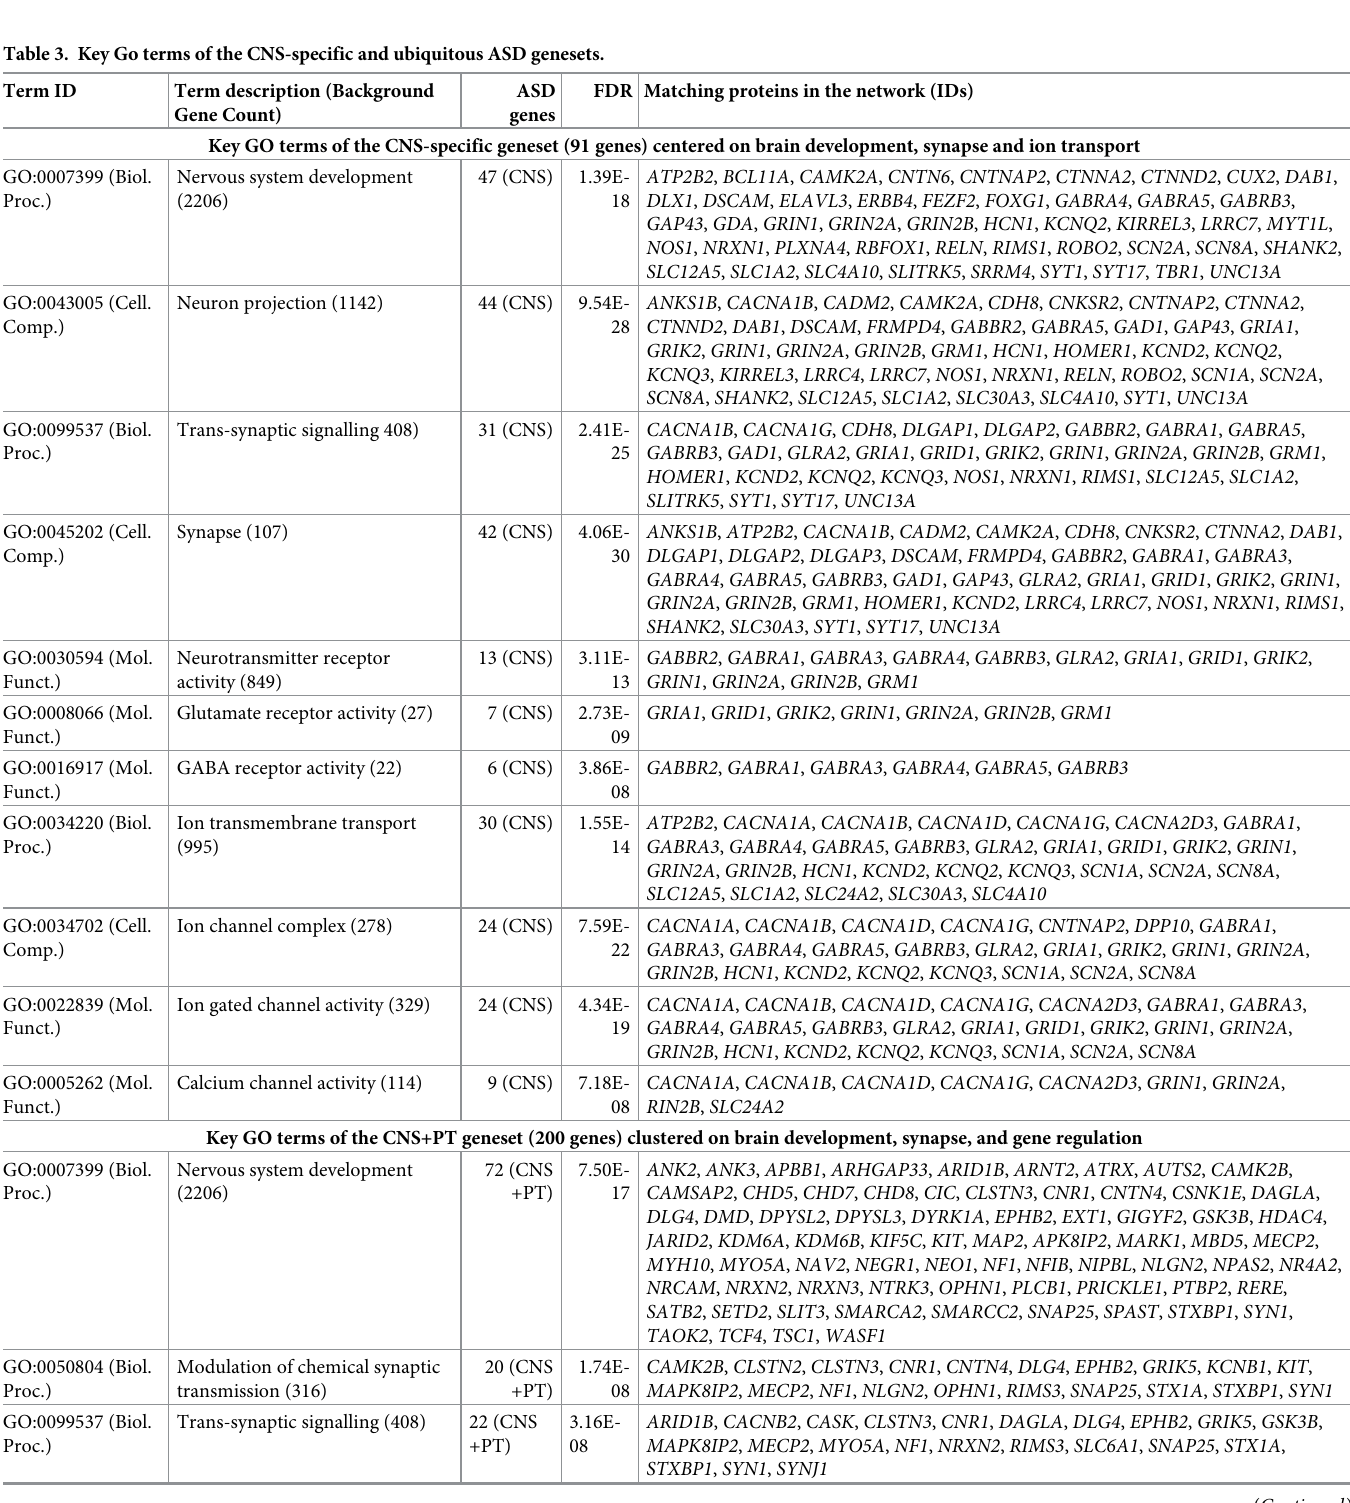
Table 3. Key Go terms of the CNS-specific and ubiquitous ASD genesets. Term ID Term description (Background Gene Count)